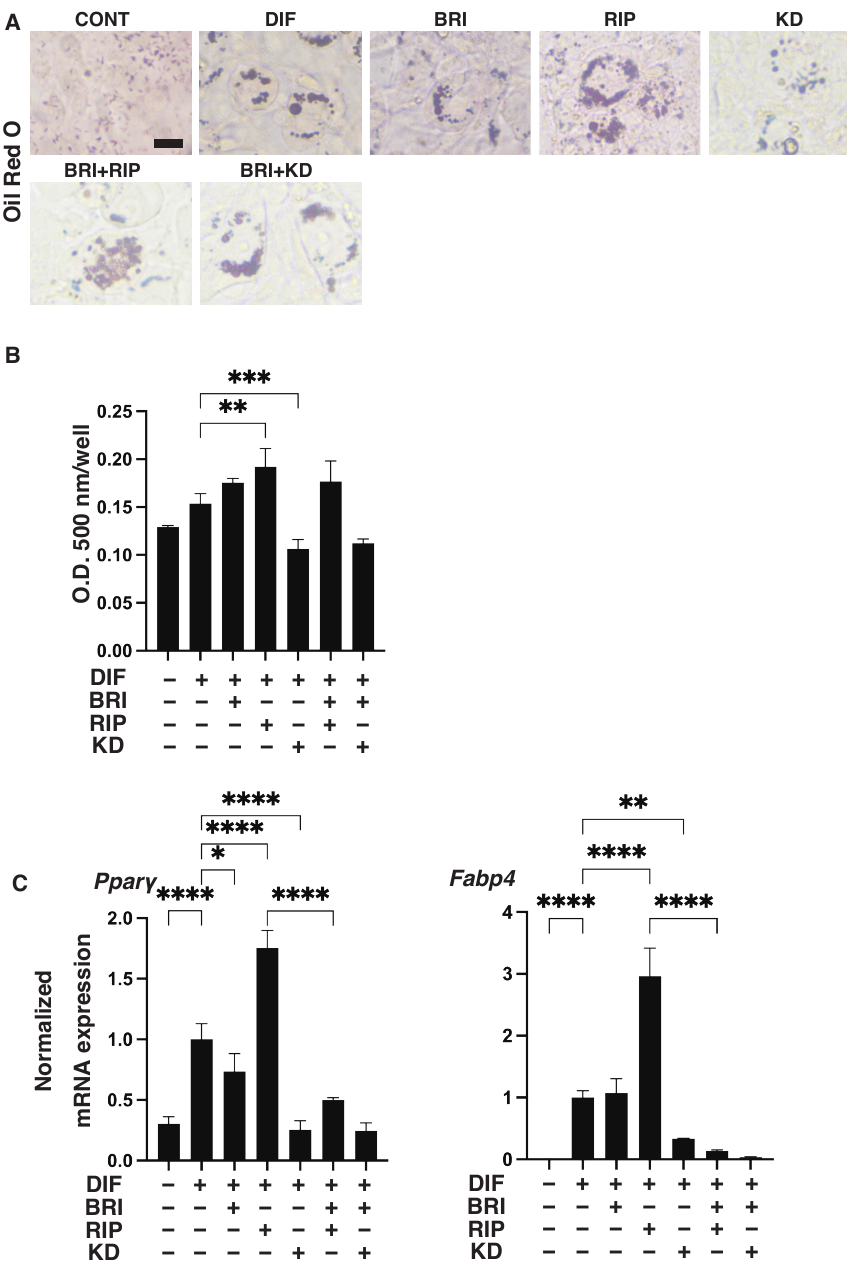
Figure 1. Effects of ROCK-is and/or BRI on adipogenic differentiation (DIF+) of 2D-cultured 3T3-L1 cells. The 3T3-L1 cells were 2D-cultured under several conditions: preadipocytes of 3T3-L1 cells (DIF − ) and their adipogenic differentiation (DIF+) with or without 10 µ M ripasudil (Rip) or KD025, and/or BRI. These were stained by Oil Red O ( A , scale bar: 100 µ m), and the staining intensities were plotted ( B ). The mRNA expressions of adipogenesis-related genes, including Ppar γ and Fabp4, under the above conditions were plotted in ( C ) 1–3. All experiments were performed in triplicate using fresh preparations, each consisting of five samples. Data are presented as the arithmetic mean ± standard error of the mean (SEM). * p <0.05, ** p <0.01, *** p <0.005, **** p <0.001, and other pairs were not statistically significant (ANOVA followed by a Tukey’s multiple comparison